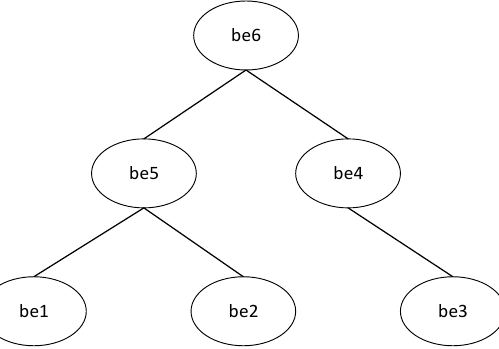
Figure 2. Business entity hierarchy-inheritance diagram.